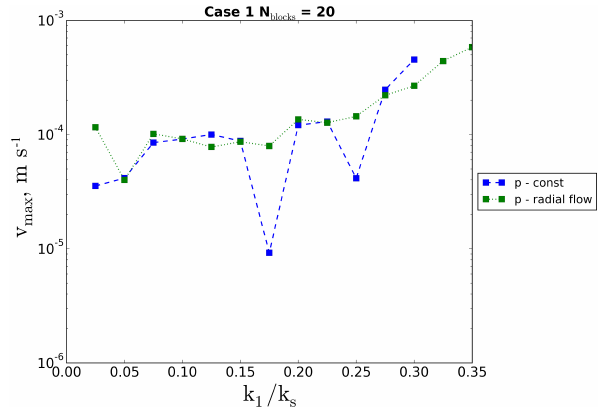
Figure 20. Maximum velocity dependence on the stiffness of the interblock link.